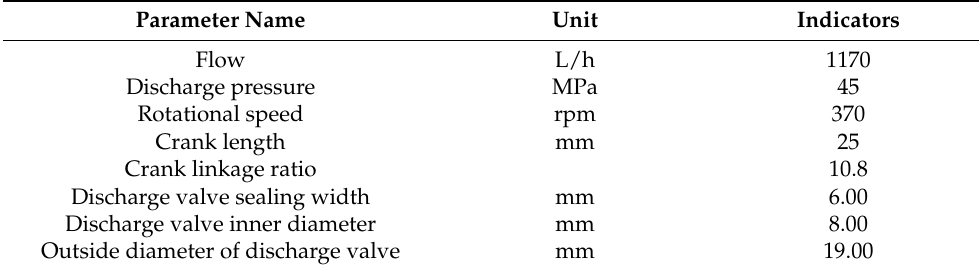
Table 1. High-pressure liquid hydrogen reciprocating pump parameters table.